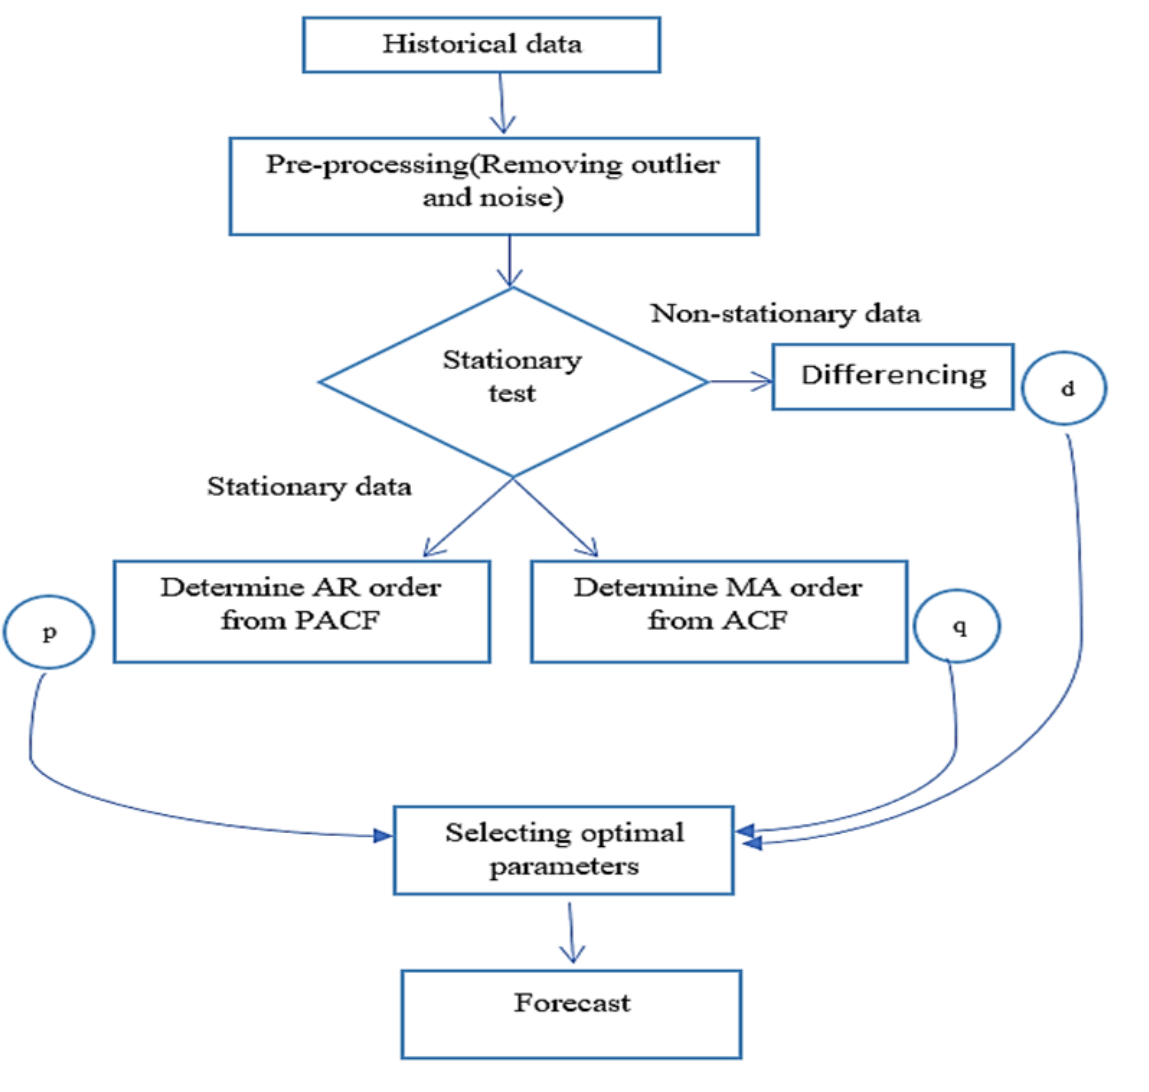
Figure 4. Methodology of forecasting using ARIMA mode.